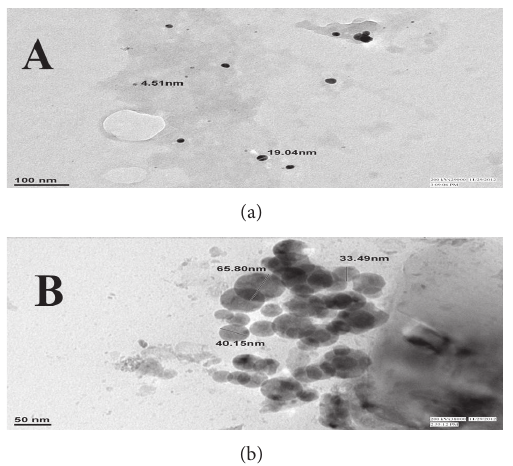
Figure 2: TEM micrographs of Cinnamomum zeylanicum synthe- sized (a) silver nanoparticles and (b) gold nanoparticles.